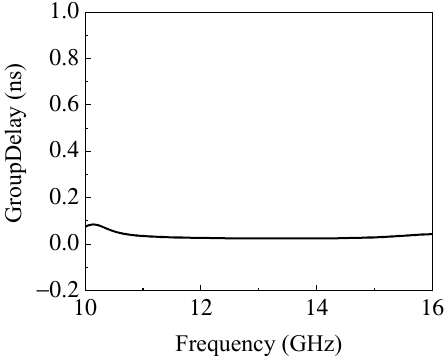
Figure 11. Group delay of the proposed UWB filter.